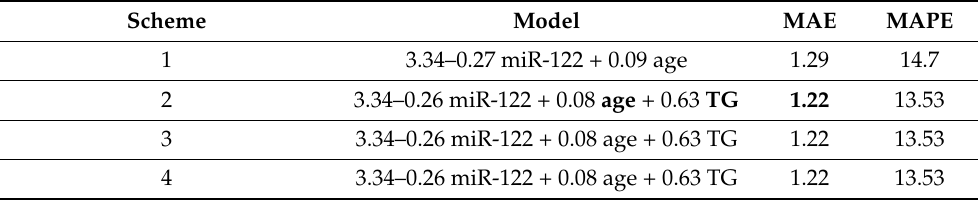
Table 7. Factors predicting